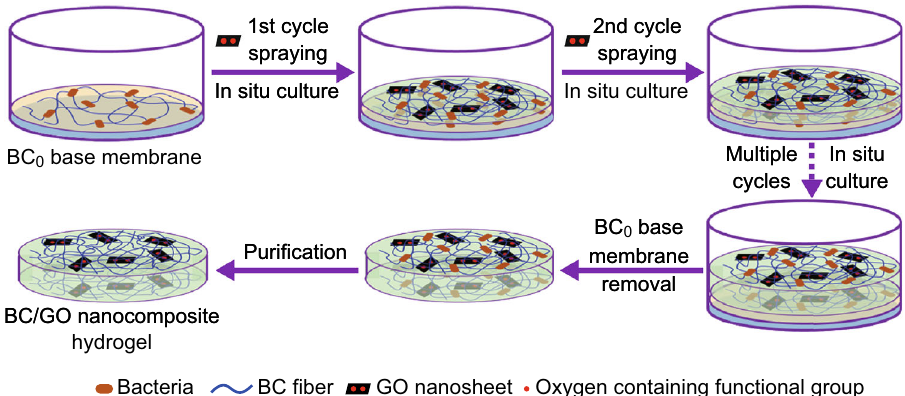
Fig. 1 Schematic illustration of the typical fabrication process of BC/GO nanocomposite hydrogel. The mixture of GO suspension and culture medium of BC was sprayed onto the BC 0 base film (in the first cycle) or the newly grown BC/GO (in the subsequent cycles) followed by in situ culture